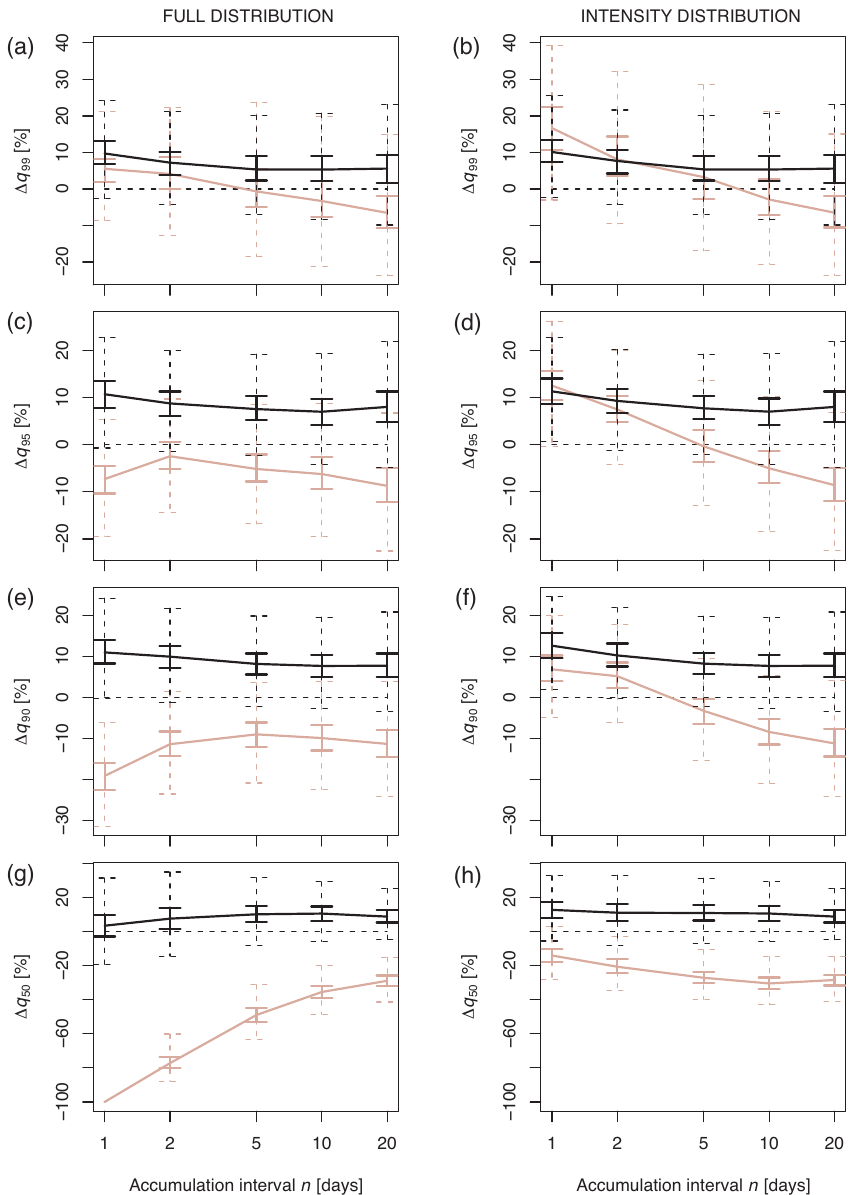
Fig. 3. The projected changes in quantiles (top to bottom: q 99 , q 95 , q 90 , q 50 ) of 1–20 day precipitation sums expected by 2070–2100 with respect to 1961–1991, for the North Rhine region. Left: full distribution quantiles. Right: intensity distribution quantiles. Results for JJA (colored) and DJF (black) are shown together in the same panel. Error bars indicate 95% confidence intervals given by bootstrapping (10000 samples) on 17 ensemble members (solid) or 1 member (dashed).